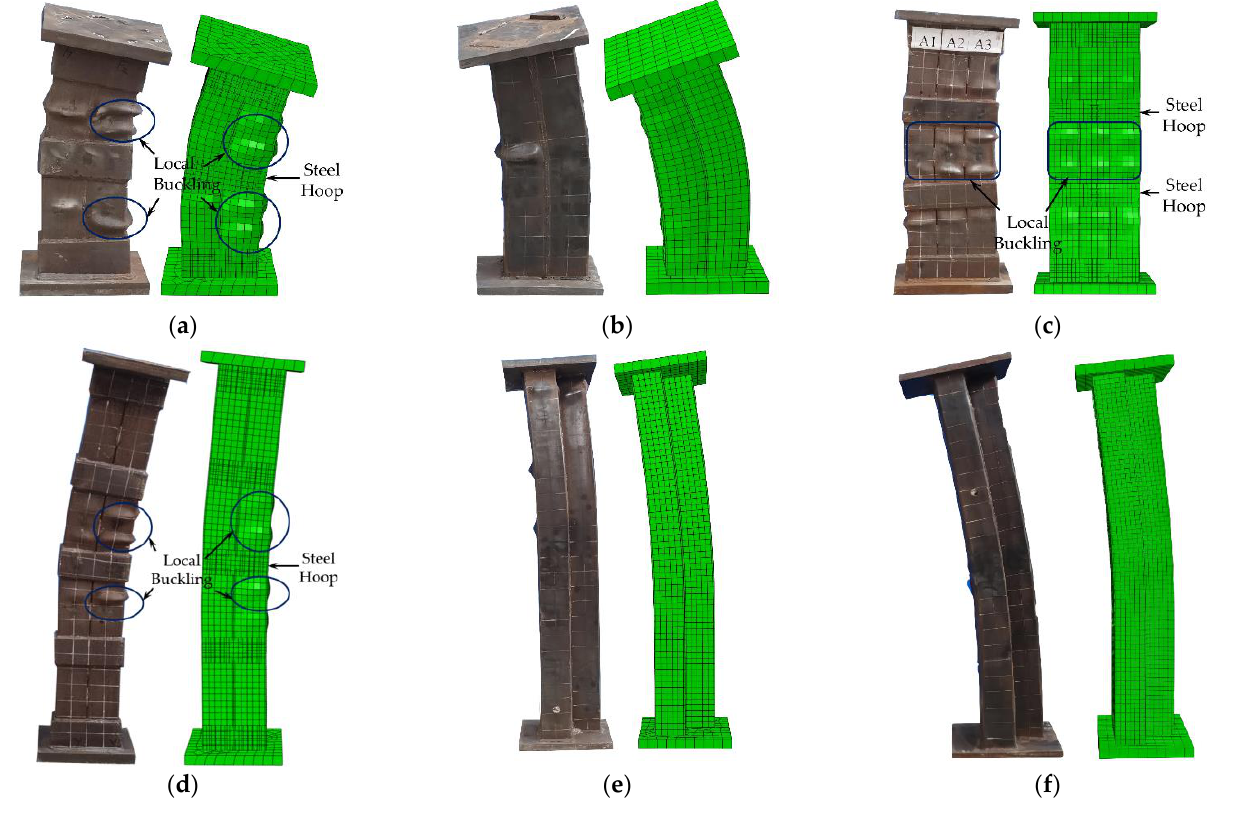
Figure 19. Comparison of failure modes between the test and FEA ( a ) HL-1; ( b ) WL-1; ( c ) HT-1; ( d ) HL-2; ( e ) WL-2; ( f ) WT-2.